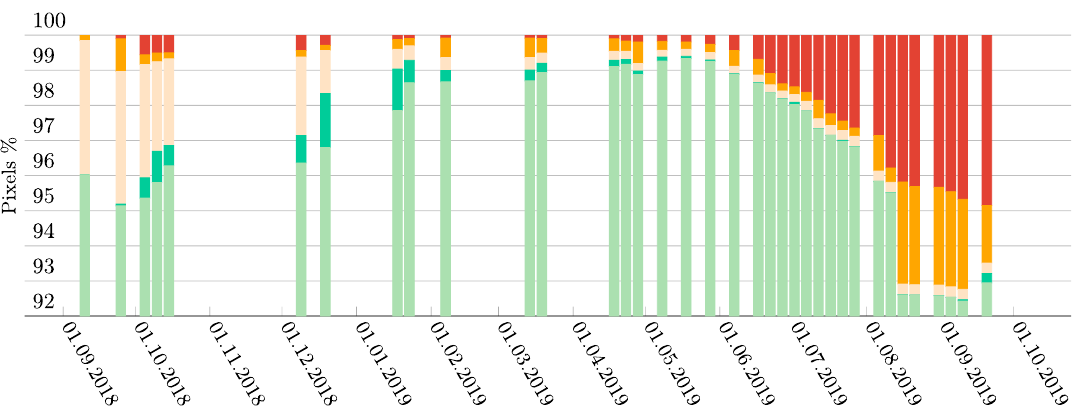
Figure 14. Pixels ’ attribution after final classification and comparison with the tim series in our one- year dataset. one-year